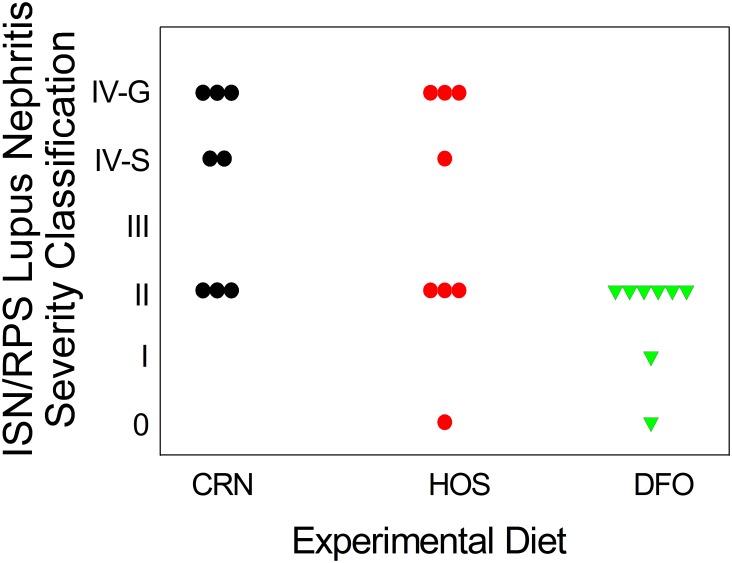
Summary of histopathological findings.Figure depicts summary of histopathological findings using ISN/RPS lupus nephritis classification system.